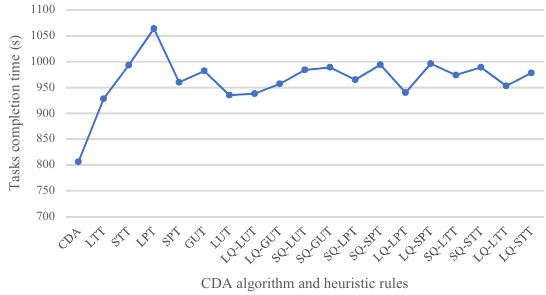
Figure A1. Curve of tasks completion time of CDA algorithm and assignment rules under different cases.